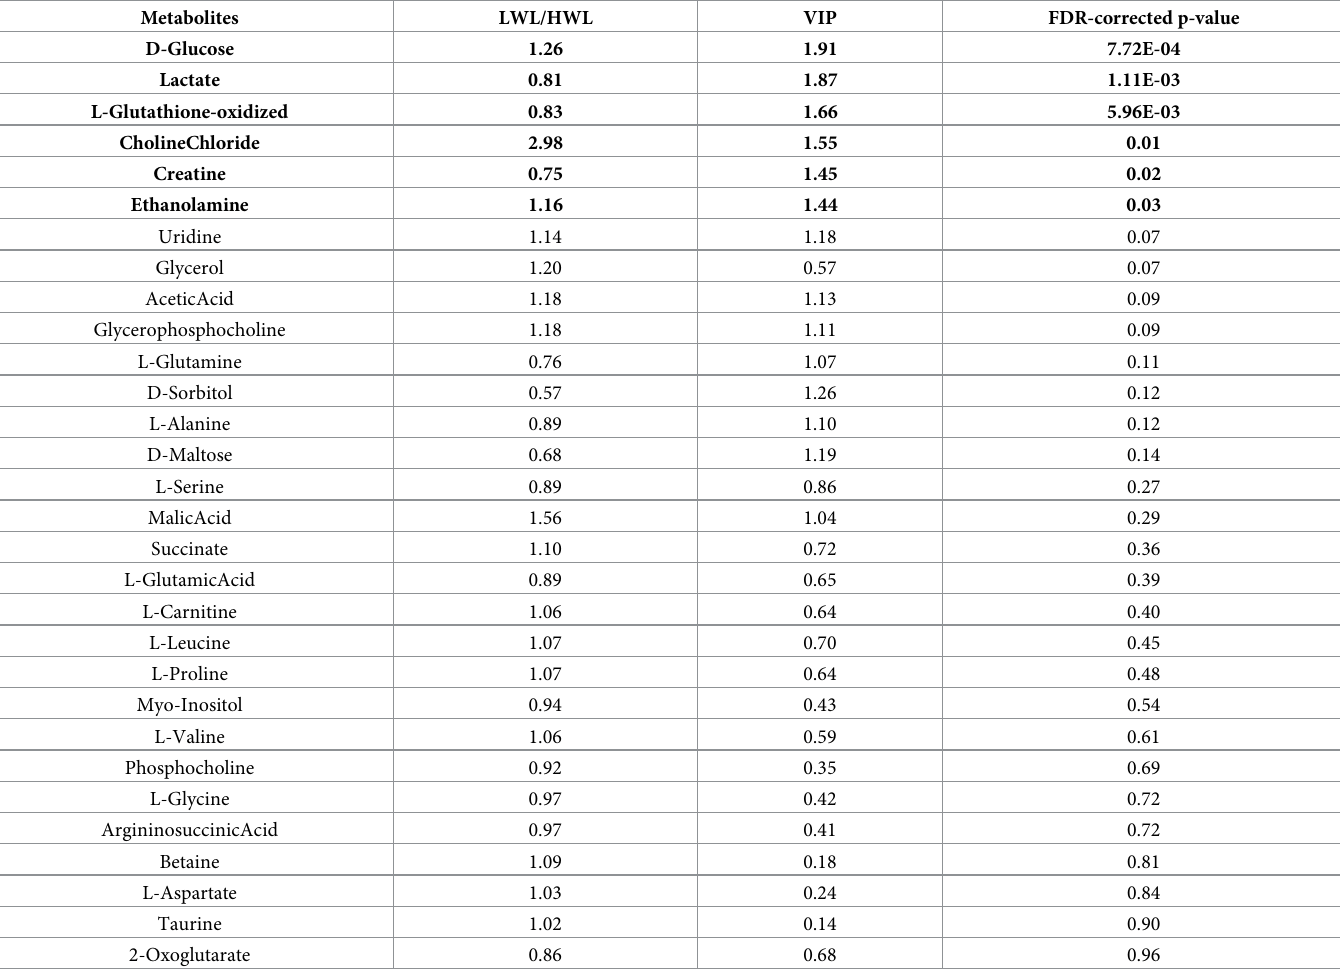
Table 3. List of the 30 metabolites identified in the samples from the LWL and/or the HLW groups. Metabolites